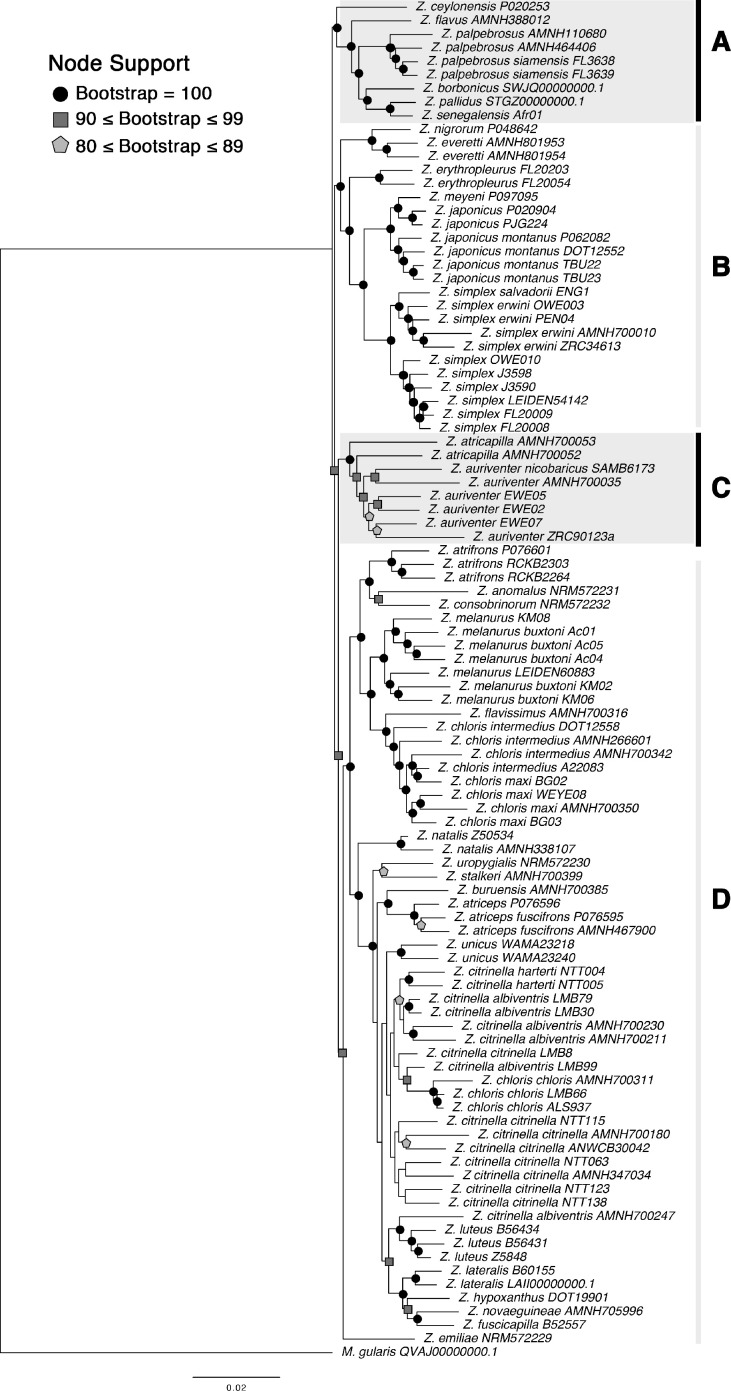
Maximum likelihood tree run with RAxML based on 770 concatenated loci.Bootstrap support value for each node is denoted by symbols: black circle = 100; dark gray square ≥90, light gray polygon ≥80, while nodes without symbols are weakly supported (<80). Clades: (A) Indo-African group, (B) Asiatic group, (C) Sundaic taxa of incongruent placement, and (D) Australasian group.